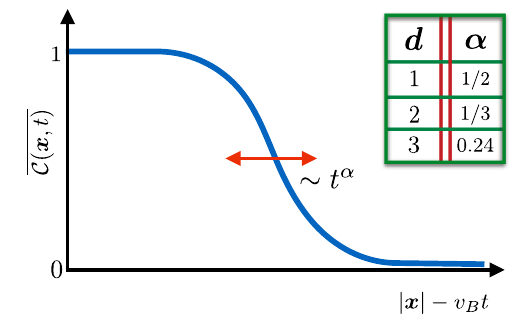
FIG. 2. Schematic behavior of the average OTOC: We find that ¯ C the average OTOC ð x ; t Þ (where the average is over the local unitaries in the quantum circuit) has a front that broadens as t α , with the indicated exponents in various spatial dimensions d